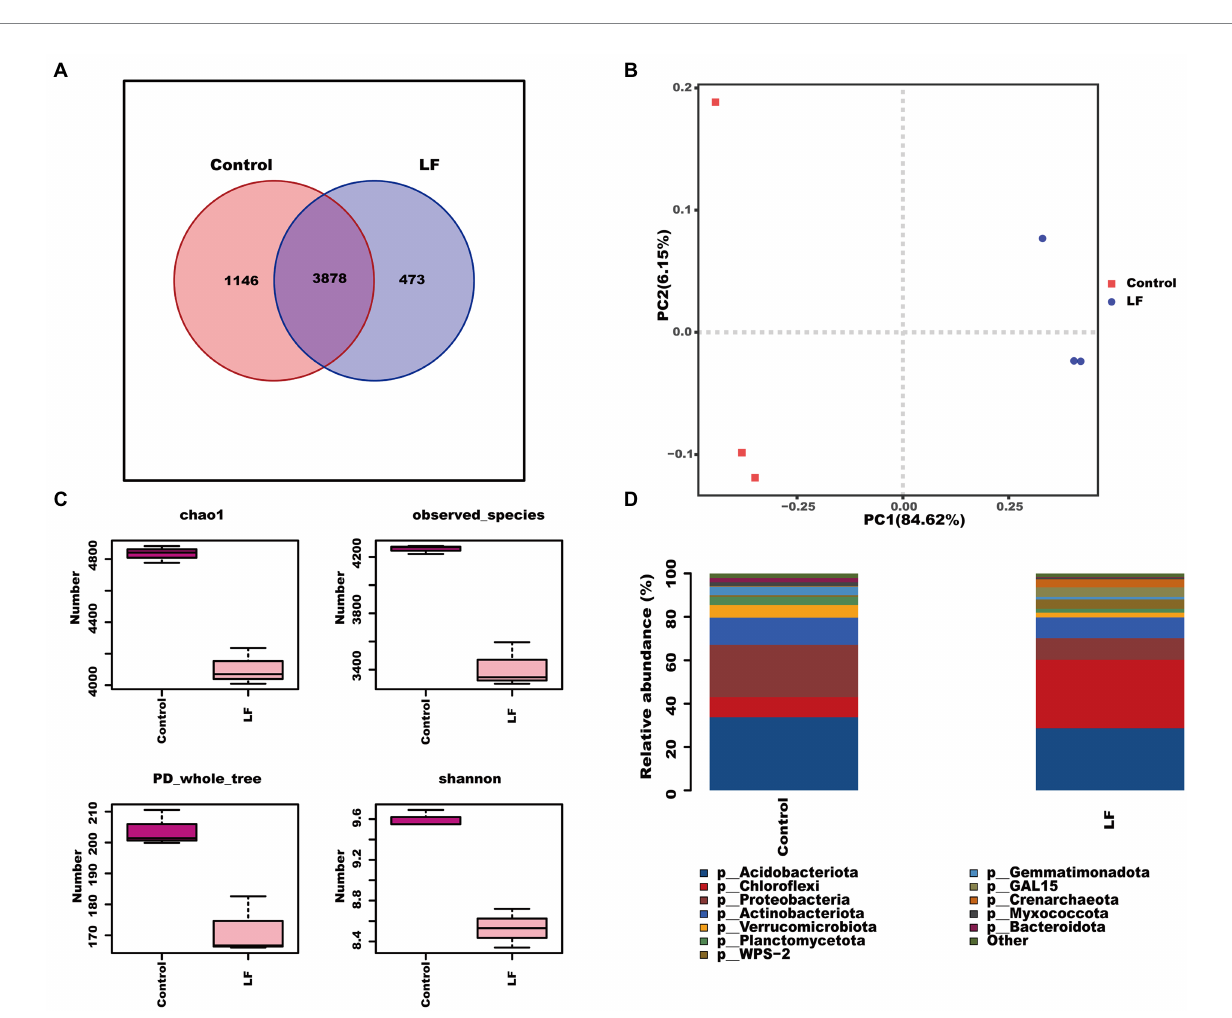
FIGURE 1 Response of rhizosphere soil biodiversity of Camellia oleifera to drought stress. (A) OTUs distribution Venn diagram; (B) PCA principal component analysis between samples; (C) alpha diversity index; (D) analysis of microbial composition at the level of